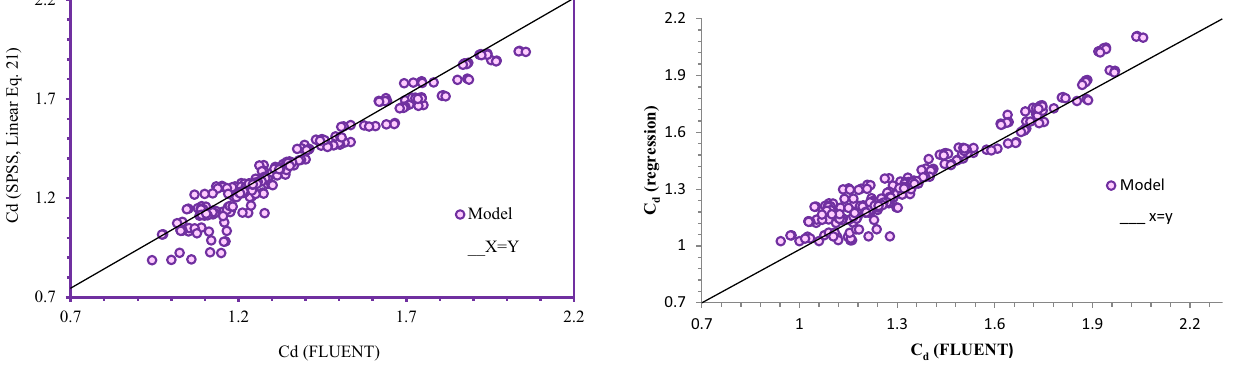
Fig. 14 Scatter plot of obtained discharge coefficients obtained from of Fluent and Eq. (22)